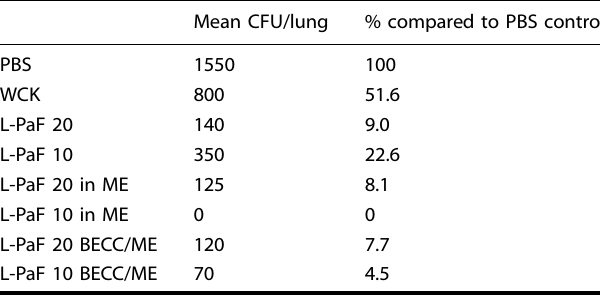
Table 1. Long term (180 DPIm) protection in CD-1 mice. Mean